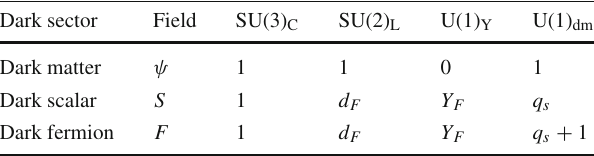
Table 1 Particle content and quantum numbers of the fermionic DM scenariowithadarkfermionandadarkscalar.Thedarksectorischarged under a global U(1) symmetry which stabilizes the DM